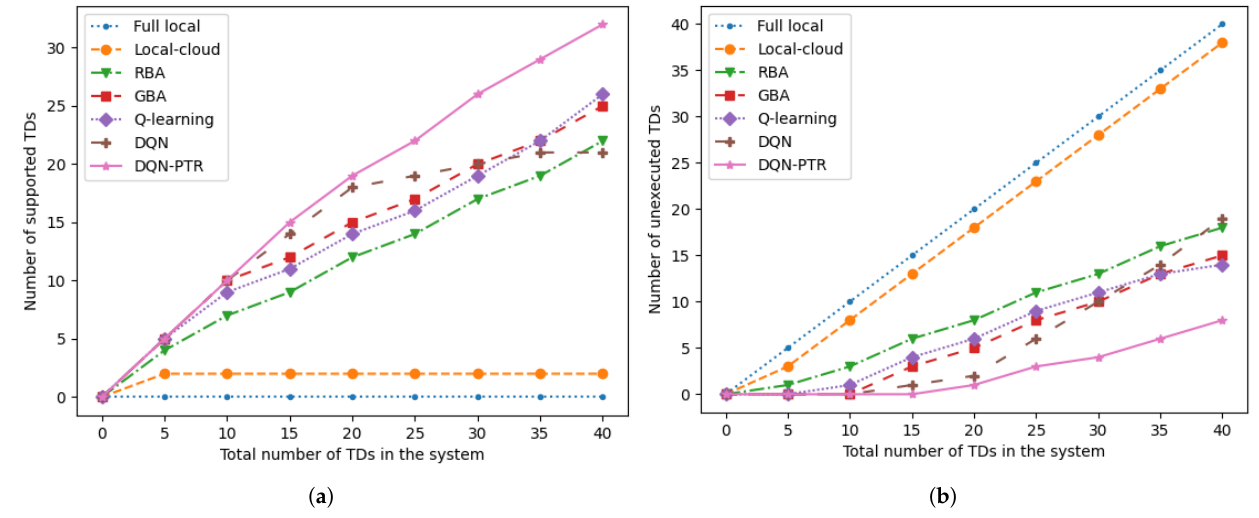
Figure 3. ( a ) The number of supported TDs versus the total number of TDs in the system. ( b ) The number of unexecuted TDs versus the total number of TDs in the system.